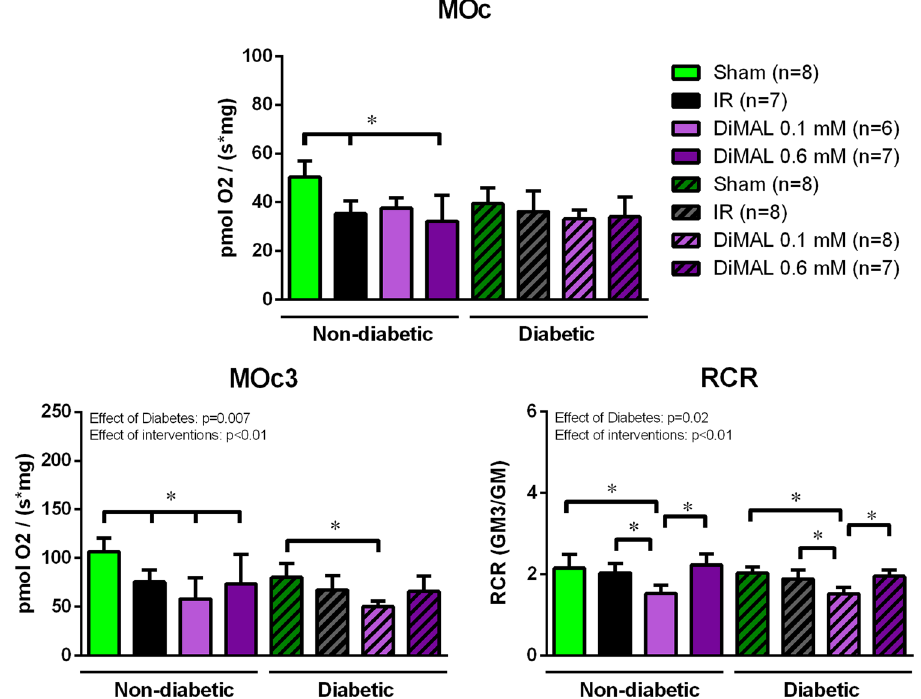
Figure 7. Isolated rat heart study - Mitochondrial fatty acid respiratory capacity. Summarized data of mitochondrial fatty acid respiratory capacity in each respiratory state. MOc, state 2 respiration with malate and octanoyl-l-carnitine; MOc3, state 3 respiration with malate and octanoyl-l-carnitine; RCR with fatty acids. Data are the mean ± SD. * P < 0.05 between indicated groups. P-values at the top indicate overall effect of diabetes and interventions by two-way ANOVA,